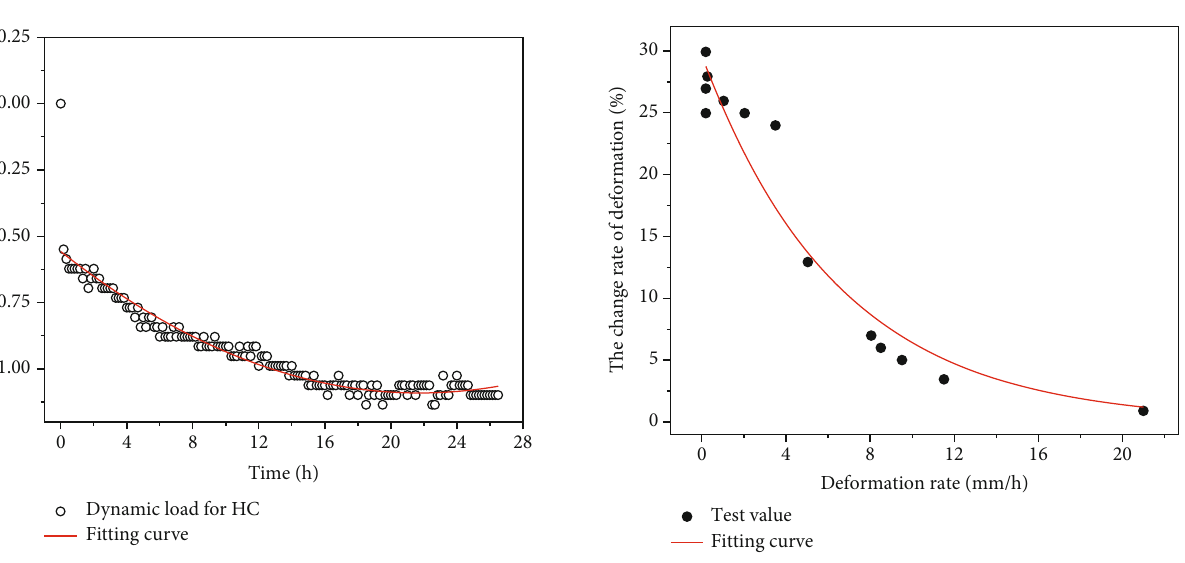
Figure 17: The change rate of deformation and time fi tting curve of soil HC.